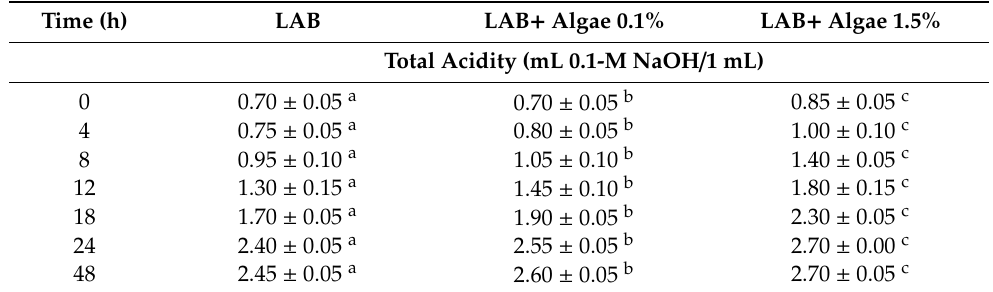
Table 3. E ff ect of algae Chlorella vulgaris on the total titratable acidity of Lactobacillus brevis ŁOCK 0992. Time (h) LAB